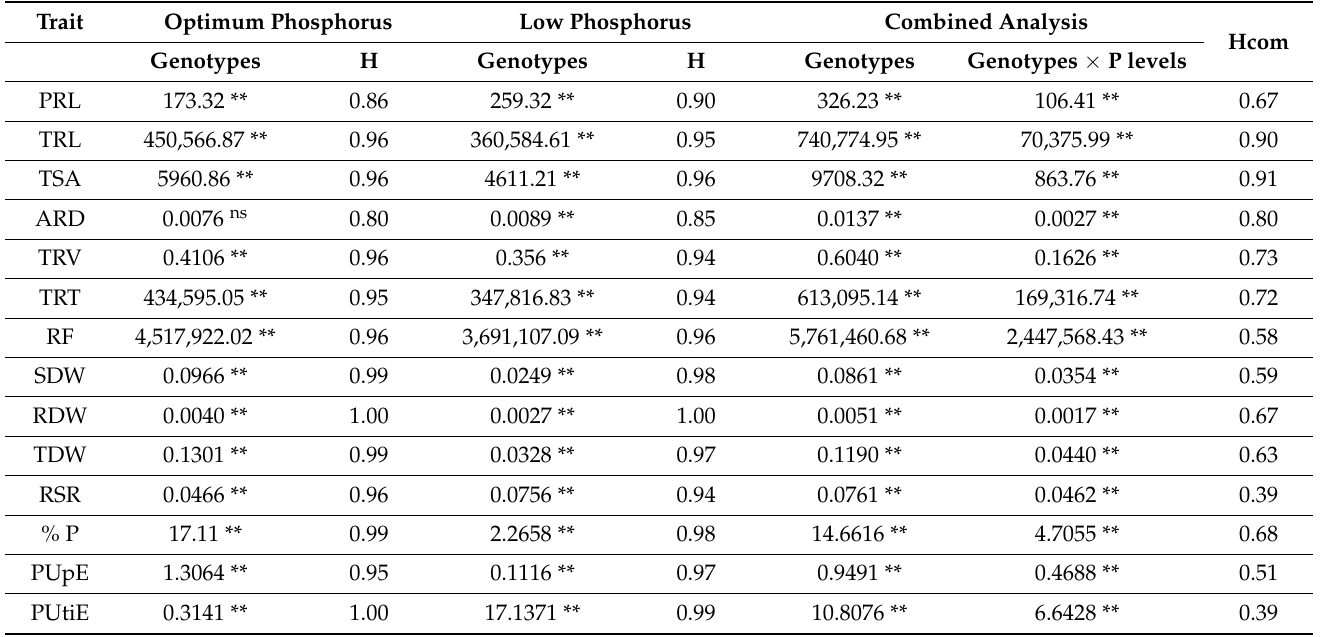
Table 2. Estimates of variance components and broad-sense heritability (H) for root and shoot traits under optimum- and low-phosphorus